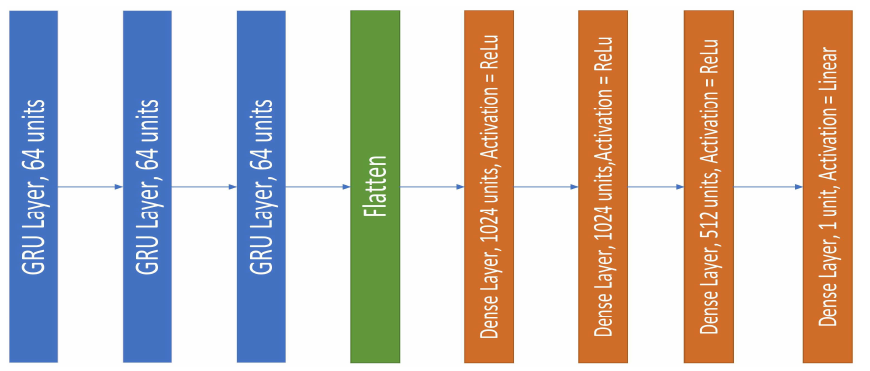
Figure 8. Architecture of the GRU model.